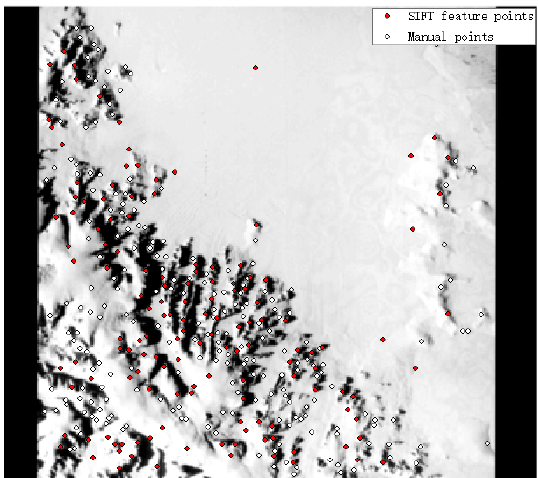
Figure 1. Distribution of SIFT feature points and manual points; red dot indicate SIFT feature points, white dot indicate manual points 3) The matching points were passed from upper layer to next Layer (Row 1 and second to the fifth layer in Table 1). According to the down sampling interval when the pyramid image was created, that one pixel on the higher layer was divided into four pixels on the next layer. So the coordinates of the matching point should multiply two when passed the matching points from upper layer to next layer. When one match point transmitted to the next level, four points that divided from passed right matching point were potential corresponding points of passed left matching points, so it is necessary to find the unique corresponding points of the left match point by re-matching. 4) The refined matching points can be as the seed points in this layer to generate a triangulated irregular network in both images respectively. Repeat step 2 and 3 until the match points were passed to the original resolution